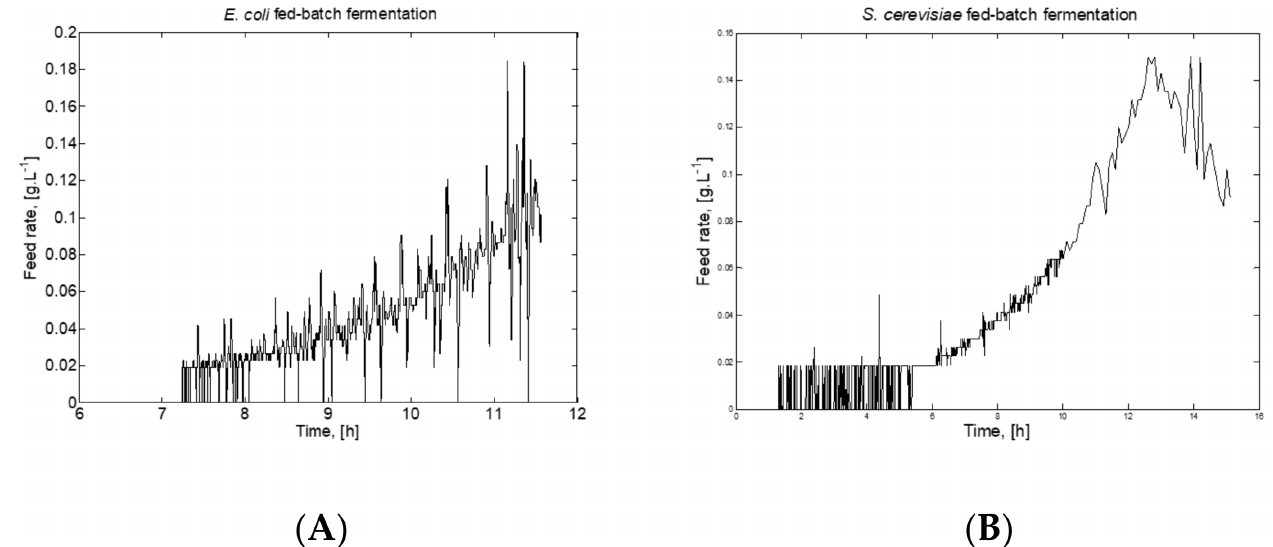
Figure 1. Feeding profiles for ( A ) E. coli and ( B ) S. cerevisiae fed-batch